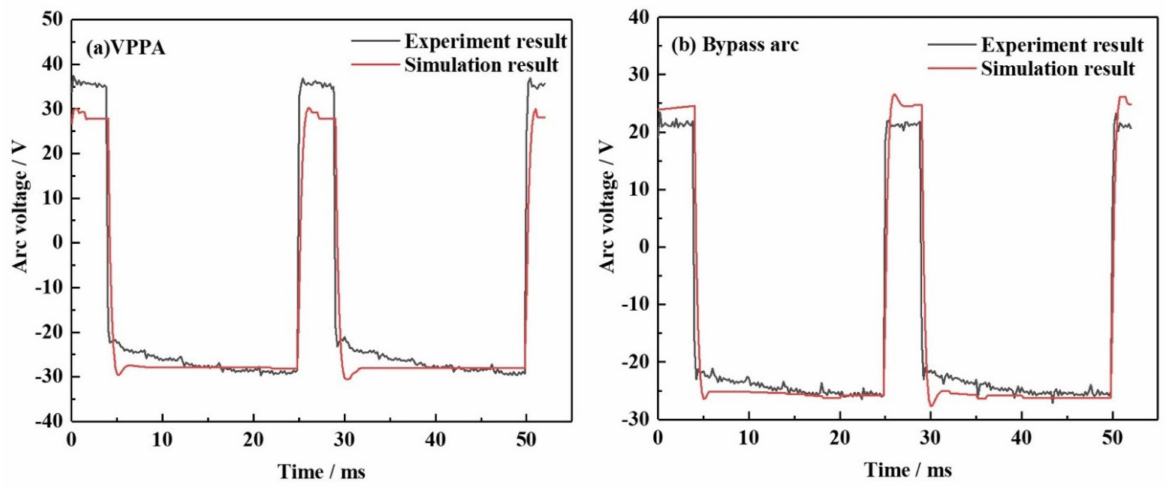
Figure 5. Voltage signals of numerical simulation and experiment: ( a ) VPPA, ( b ) bypass